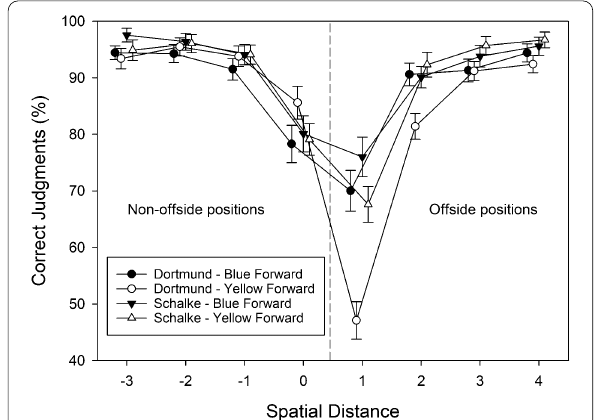
Fig. 3 The percentage of correct offside judgments observed in Experiment 1, plotted as a function of spatial distance (between forward and defender), participants’ team preference (Dortmund vs. Schalke), and shirt color of the attacking team (blue vs. yellow). Error bars represent standard errors between participants. For each level of spatial distance, data points are jittered to increase